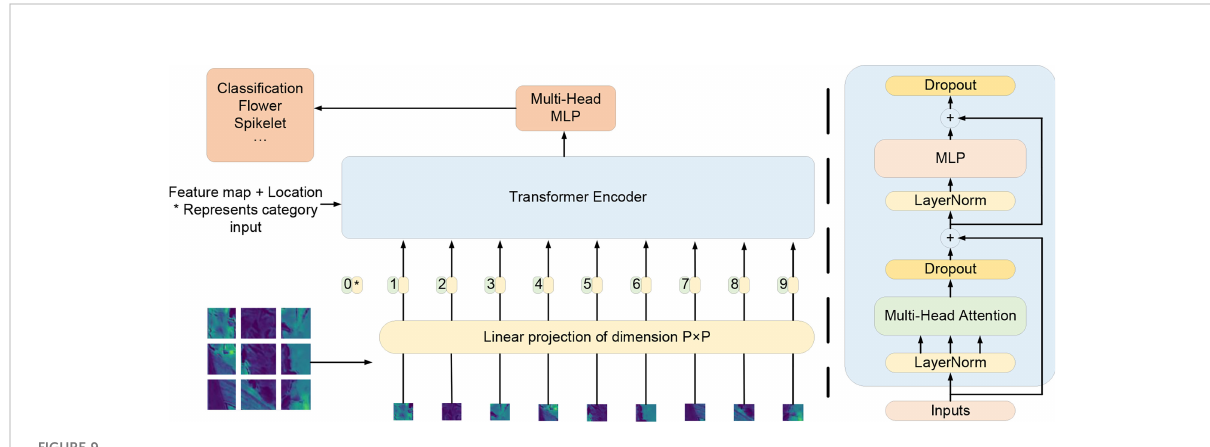
FIGURE 9 The diagram of transformer encoder structure.